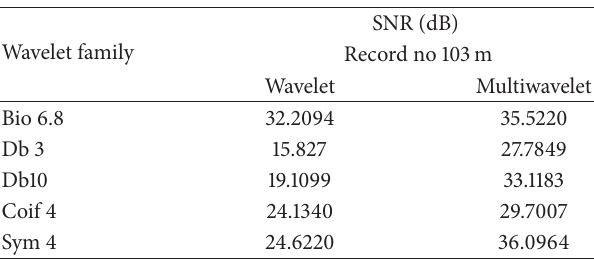
Table 2: Performance comparison of wavelet and multiwavelet for record